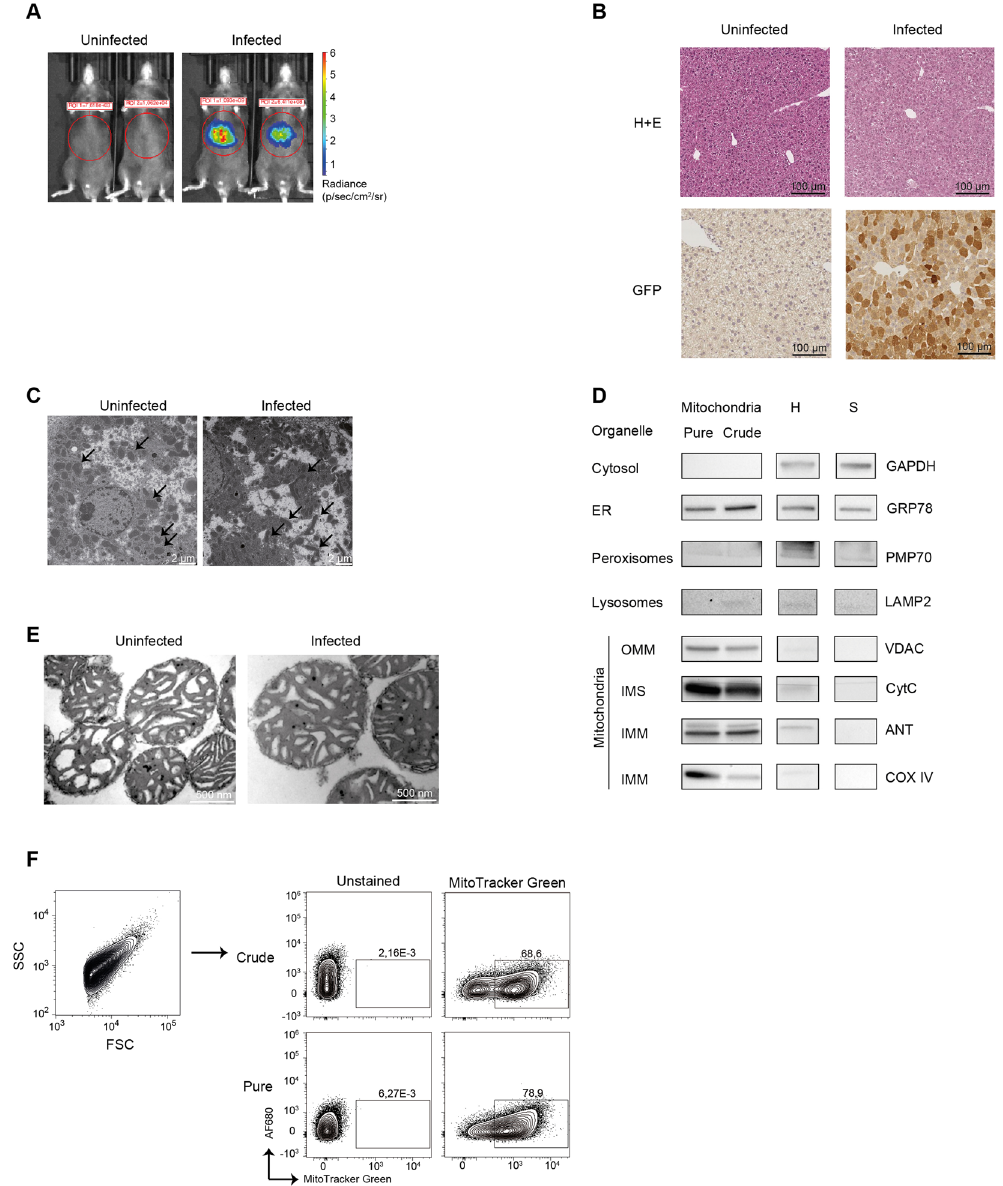
Figure 1. Viral infection changes mitochondrial size and membrane potential. ( A ) Bioluminescence imaging of mice two days after infection with Ad-CMV-GOL (5 × 10 8 pfu/mouse). ( B ) H + E histochemical staining and GFP immunohistochemical staining (brown) of liver sections from mice infected two days before with Ad-CMV-GOL (5 × 10 8 pfu/mouse). Scale bar = 100 µ m. ( C ) Electron microscopy of liver sections from mice uninfected (left) and infected (right) with 5 × 10 8 pfu/mouse Ad-CMV-GOL. Liver was removed two days after infection, fixed and subjected to electron microscopy. Arrows indicate mitochondria. Scale Bar = 2 µ m. ( D ) Western blot analysis of mitochondria isolations (crude and after gradient purification (pure)). Detection of cellular proteins of distinct organelles, cytosol and compartments of isolated mitochondria compared to total liver homogenate (H) and supernatant of mitochondria pellet (S). Abbreviations: OMM = outer mitochondrial membrane; IMS = Intermembrane space; IMM = Inner mitochondrial membrane. GRP78, VDAC and Cyt C were detected on one Blot after cropping of the membrane. Lamp2 and GAPDH were detected on the same Blot after striping of first antibodies. PMP70, ANT and COX4 were detected together on a separate cropped blot. Exposure times are as follows: GAPDH 10 s; GRP78 95 s; Cyt C, ANT, and COX4 180 s; VDAC 1115 s; LAMP2 1200 s. ( E ) Electron microscopy of purified mitochondria isolated from healthy and Ad-CMV-GOL livers as in (C) Scale bar = 500 nm. ( F ) Flow cytometric analysis of isolated mitochondria pre (crude) and post purification via gradient (pure) stained with Mitotracker Green FM (200 nM). Representative data from at least three independent